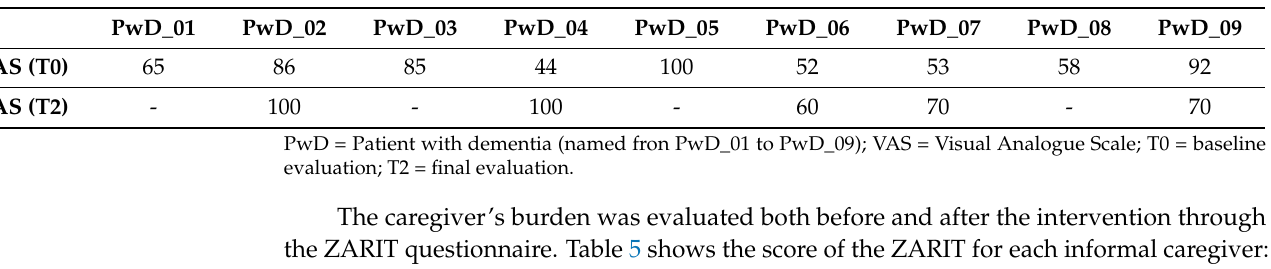
Table 4. VAS scores of PwD at the beginning and at the end of the test.